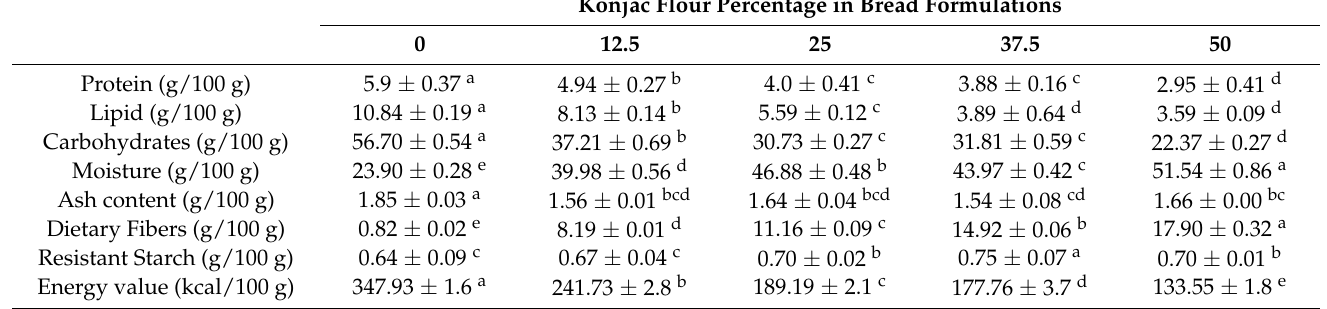
Table 2. Chemical composition of different formulations of gluten-free bread with and without konjac flour addition on a wet